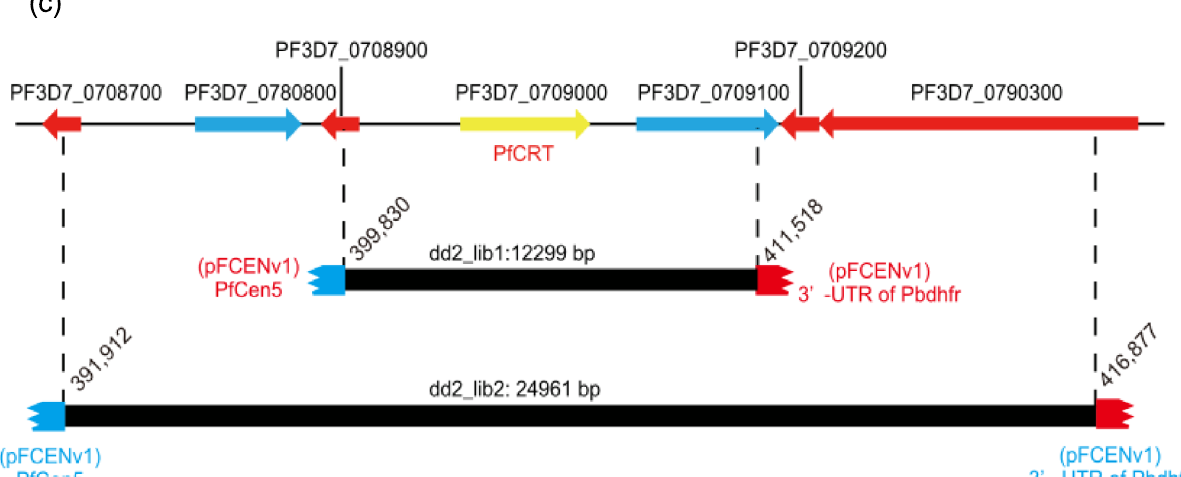
thenegativecontrolparasitewasalsodetermined.Allassayswereperformedusing n =4biologicalindependentsamples.ErrorbarsareSEM.Thecolorspeci fi cationis thesameasthatusedin a . c GenomicDNAfragmentswereobtainedfromsurviving parasites in dd2-lib1 and 2. DNA fragments overlapped at the genomic region encoding the pfcrt gene. Source data are provided as a Source Data fi